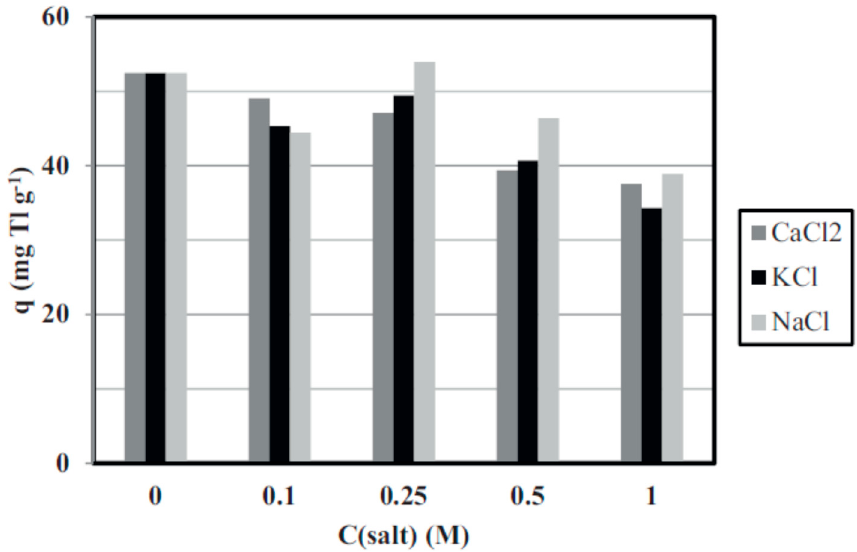
Figure 4. Effect of increasing concentration of salts (of alkali and alkaline-earth metal salts) on Tl(I) sorption capacity (reprinted with permission from Elsevier, [164]).